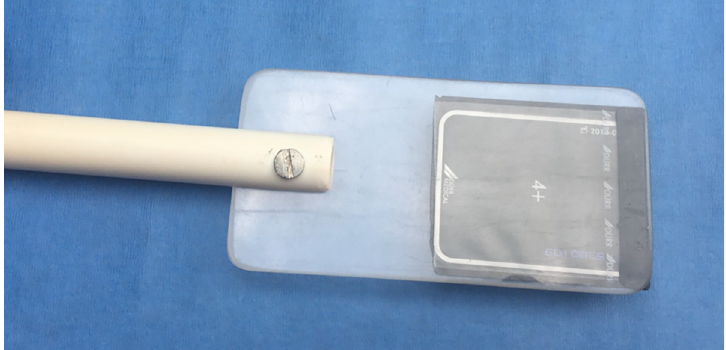
Fig 1. Film holder for dental radiography. A plate holder was manufactured from two appropriately sized translucent plexiglass sheets affixed on the end of a ½ inch PVC pipe. A high-resolution standard dental #4 size digital phosphor plate was encased in a sealed plastic sleeve, inserted between the plexiglass sheets and positioned in the dolphin’s mouth for dental radiographs.